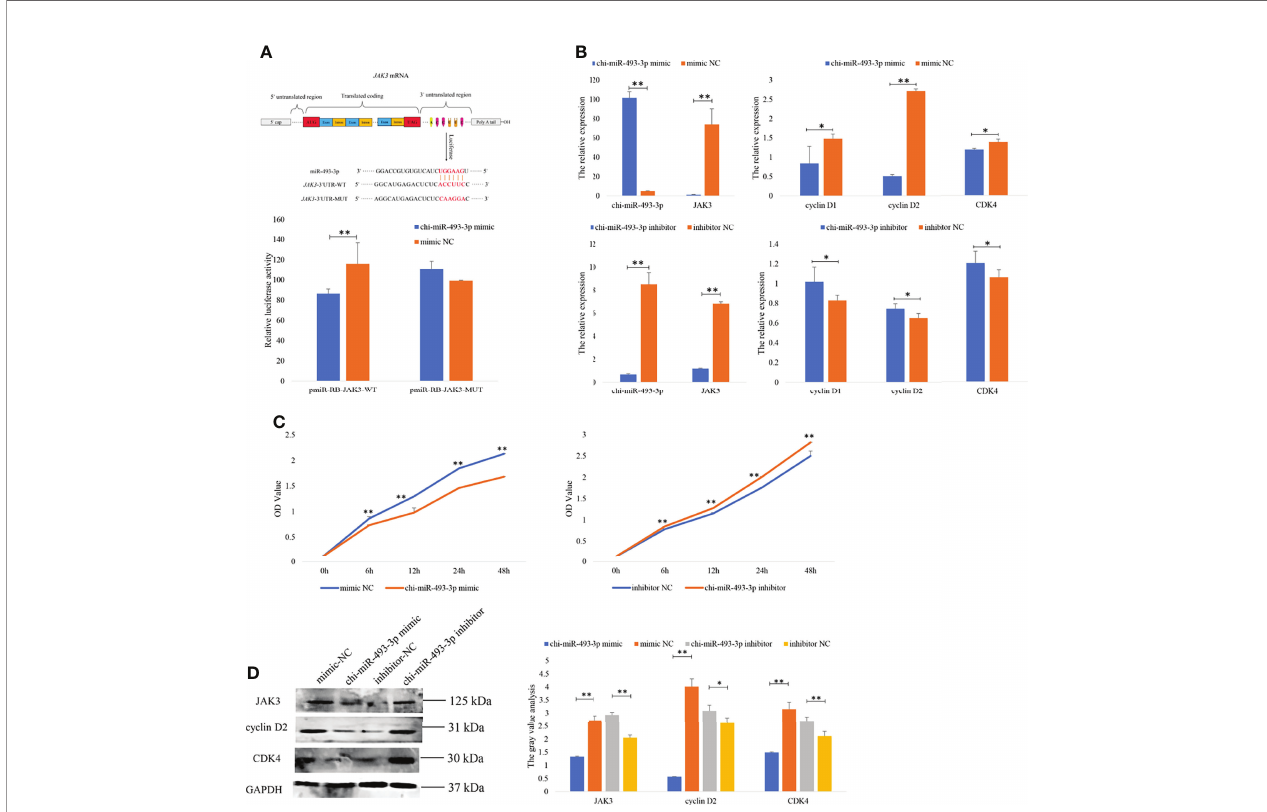
FIGURE 6 | chi-miR-493-3p speci fi cally targets JAK3 in goat granulosa cells. (A) Target sites for chi-miR-493-3p in the JAK3 3 ’ -UTR and the construction of the luciferase expression vector (Luc) fused with the JAK3 3 ’ -UTR. JAK3-3 ’ UTR-WT represents the Luc reporter vector with the wild-type JAK3 3 ’ -UTR; JAK3-3 ’ UTR- MUT represents the Luc reporter vector with the mutation at the chi-miR-493-3p site in JAK3 3 ’ -UTR. After HEK293T cells transfected chi-miR-493-3p mimic or mimics NC with WT-/MUT-Luc reporter vectors for 48h, the relative luciferase activities are measured. The (B) mRNA expressions of JAK3, cyclin D1, cyclin D2 , and CDK4 in granulosa cells transfected with chi-miR-493-3p-mimic/-inhibitor or mimic/inhibitor NC for 48h are quanti fi ed using RT-qPCR. RPL19 is used as an internal control. (C) The CCK8 assay analysis in granulosa cells transfected with chi-miR-493-3p-mimic/-inhibitor or mimic/inhibitor NC for 48h. (D) The protein expressions